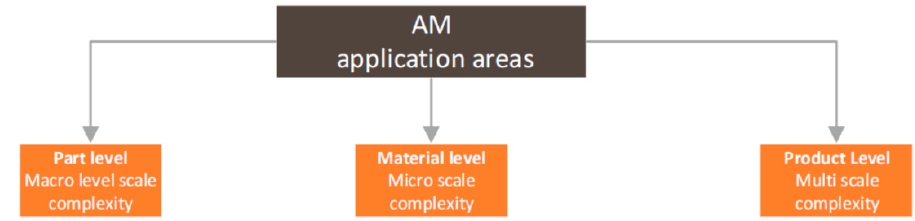
Figure 3. AM application areas, based on [26].